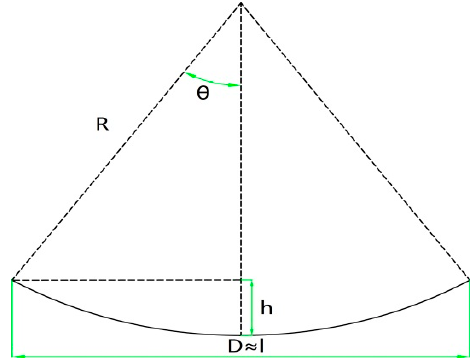
Figure 7. Schema of substrate surface.